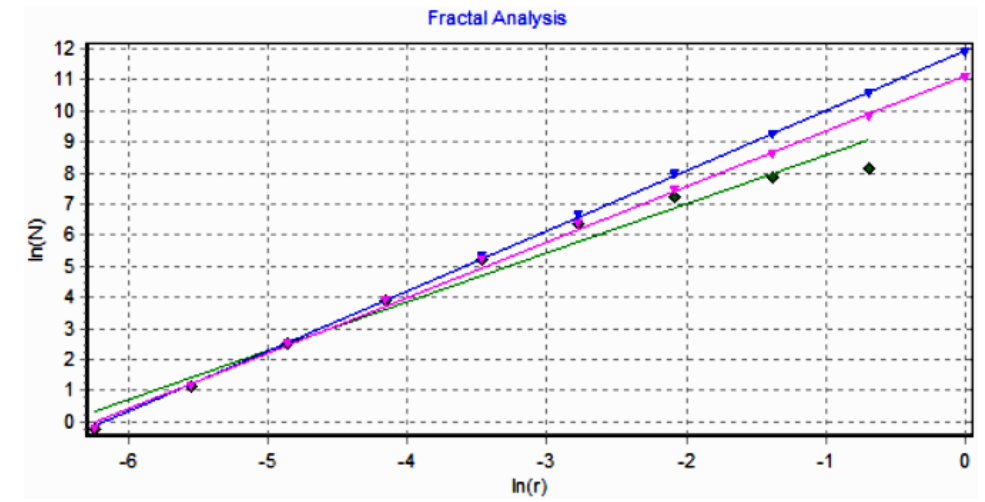
Figure 9. Graphic of fractal dimension for selected U 1 image area.